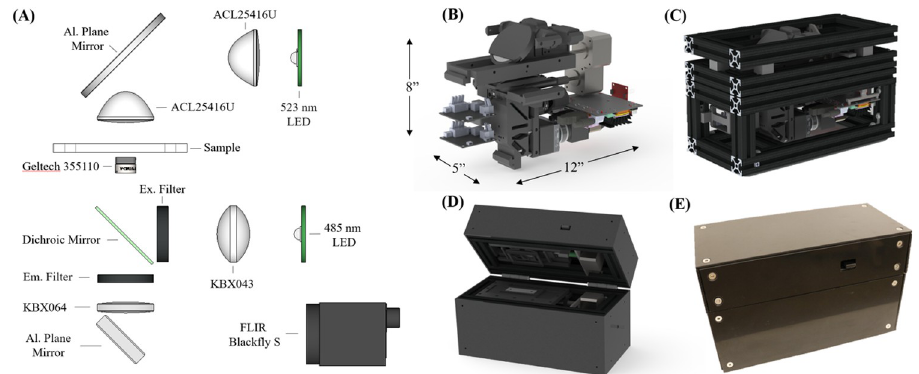
Fig 1. (A) Layout of optical components in the portable microscope. CAD models of microscope: (B) optomechanical mounts and electronic control components, (C) extruded aluminum frame, and (D) fully encased prototype demonstrating clamshell design. (E) Final physical prototype